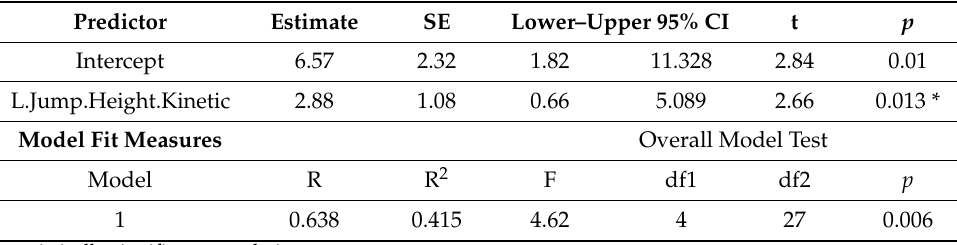
Table 6. Linear regression of non-dominant side (based on